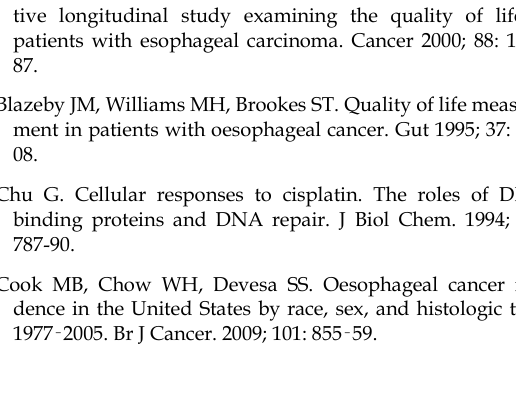
Figure 5: Casticin promoted the expression of proapoptotic protein, Bax and activation of cleaved caspase-3 in TE-1